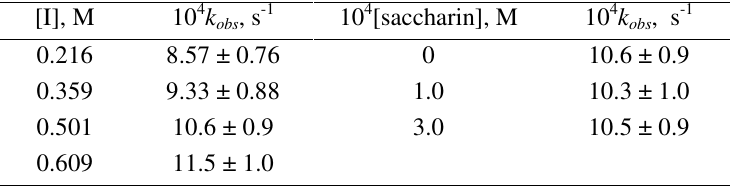
Table 2. Influence of ionic strength and saccharin on reaction rate for the oxidation of PTAA with NCSA